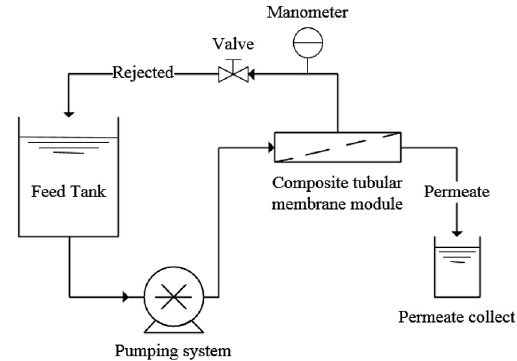
Figure 1. System used in the process of